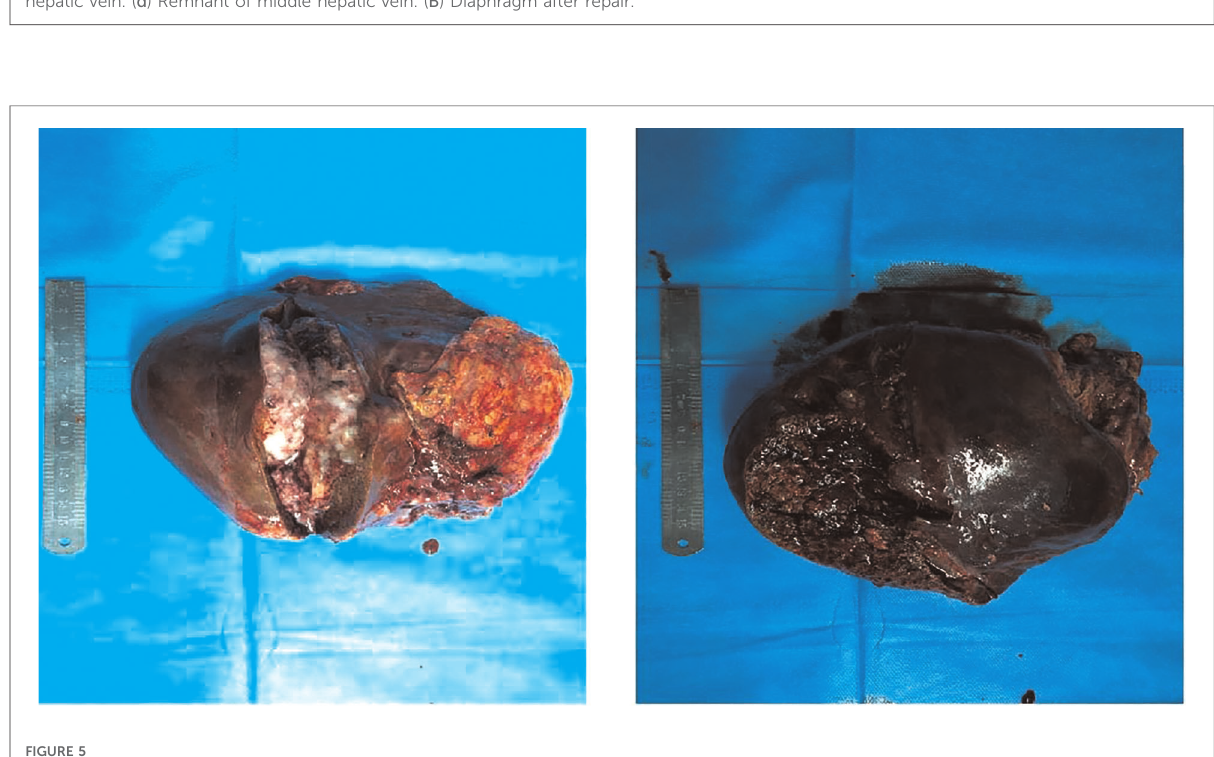
FIGURE 5 Resectted tumor